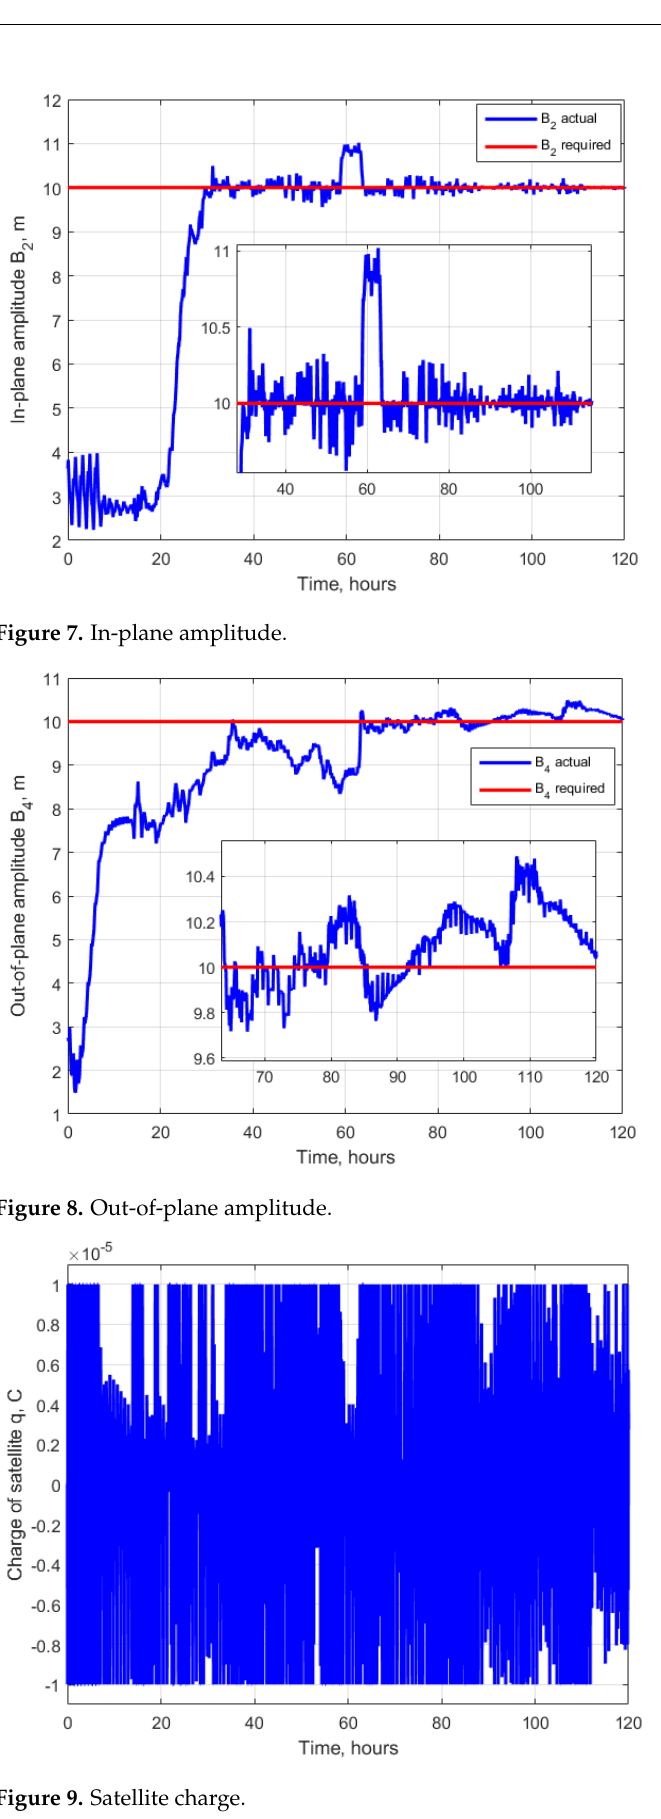
Figure 6. Relative shift.